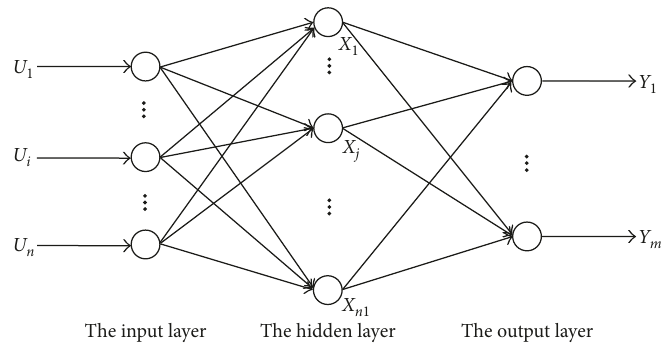
Figure 1: The general structure of BPNN model.